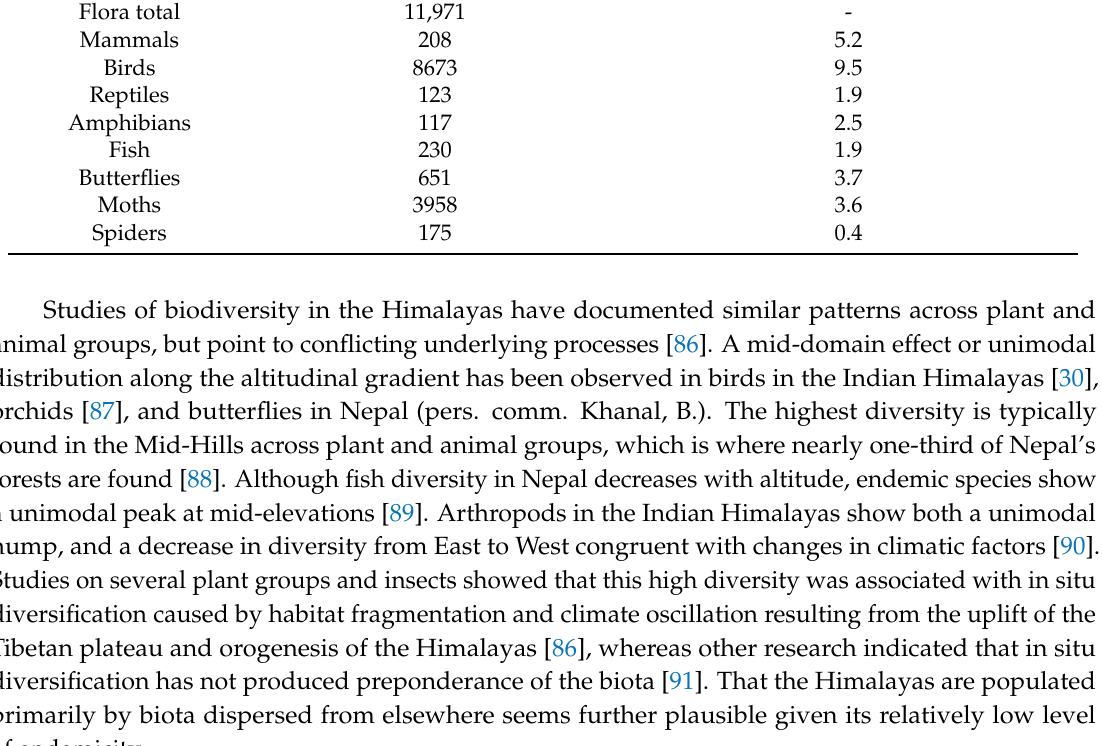
Table 1. Taken from the Ministry of Forest and Soil Conservation, Government of Nepal (2014) [83]. Group Number of Observed Species % Relative to Known Species Worldwide Angiosperms 6973 3.2 Gymnosperms 26 5.1 Pteridophytes 534 5.1 Bryophytes 1150 8.2 Lichens 465 2.3 Fungi 1822 2.6 Algae 1001 2.5 Flora total 11,971 - Mammals 208 5.2 Birds 8673 9.5 Reptiles 123 1.9 Amphibians 117 2.5 Fish 230 1.9 Butterflies 651 3.7 Moths 3958 3.6 Spiders 175